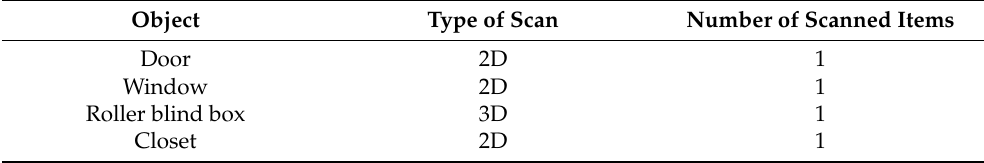
Table 4. Object scanned under the data enrichment process for Division 02 (bedroom).